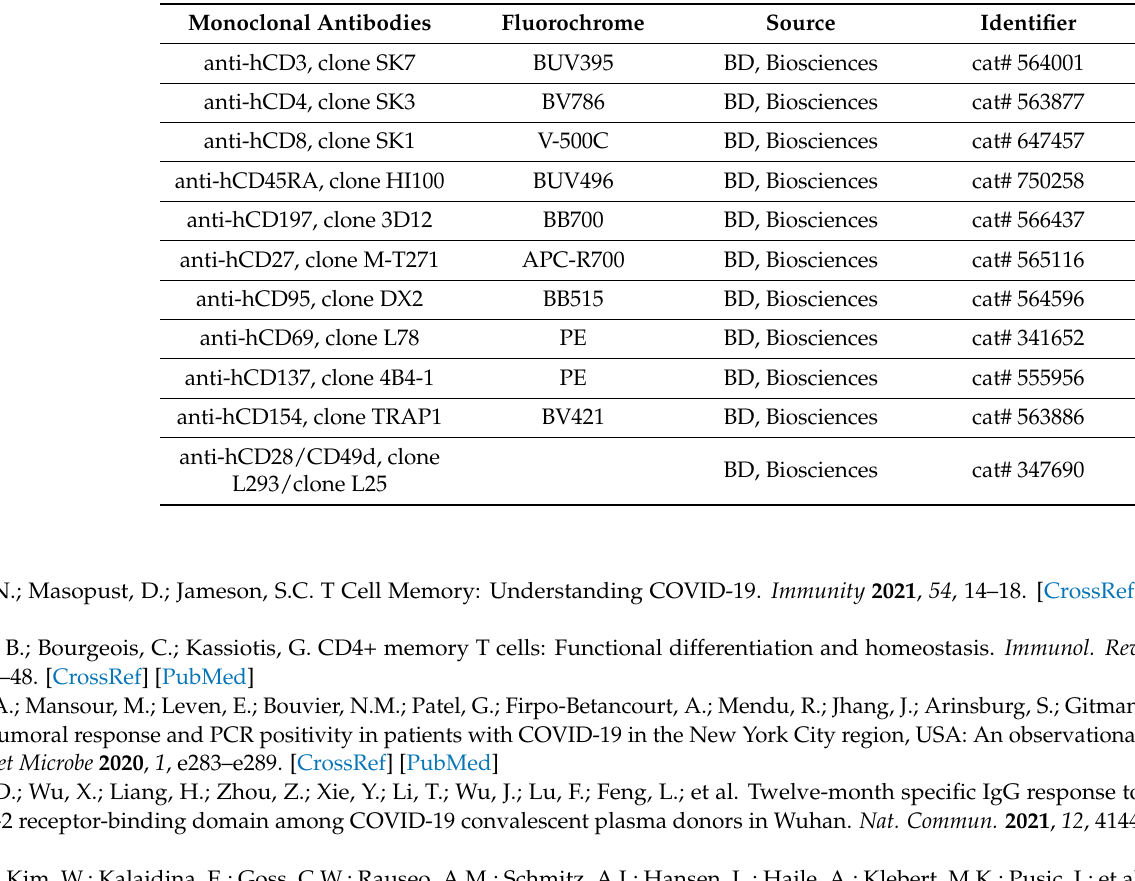
Figure A1. Flow chart of participants and experiments performed. Table A3. The following monoclonal antibodies were used for multi-color flow cytometry.